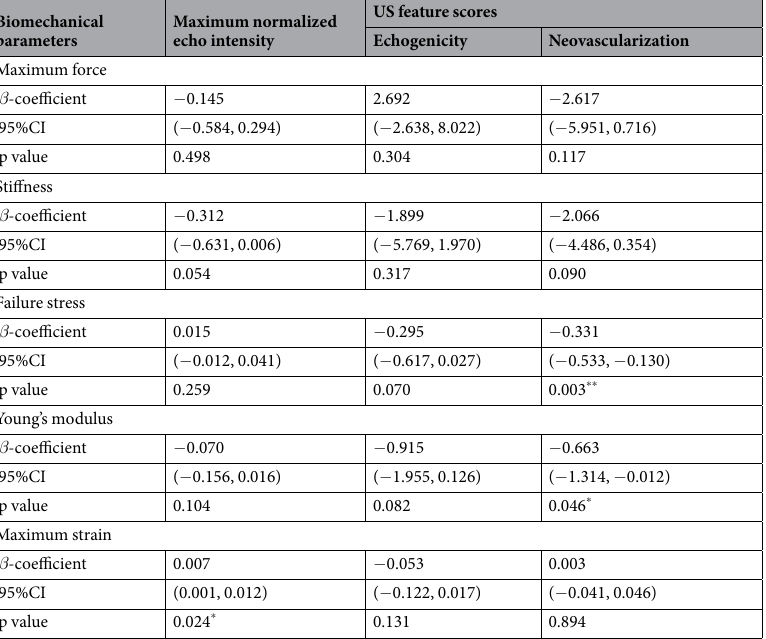
Table 3. Association between biomechanical parameters and characteristics of ultrasonography in the injured tendons. The β -coefficient and the corresponding 95% CI were estimated from the linear regression model; * p < 0.05, ** p <